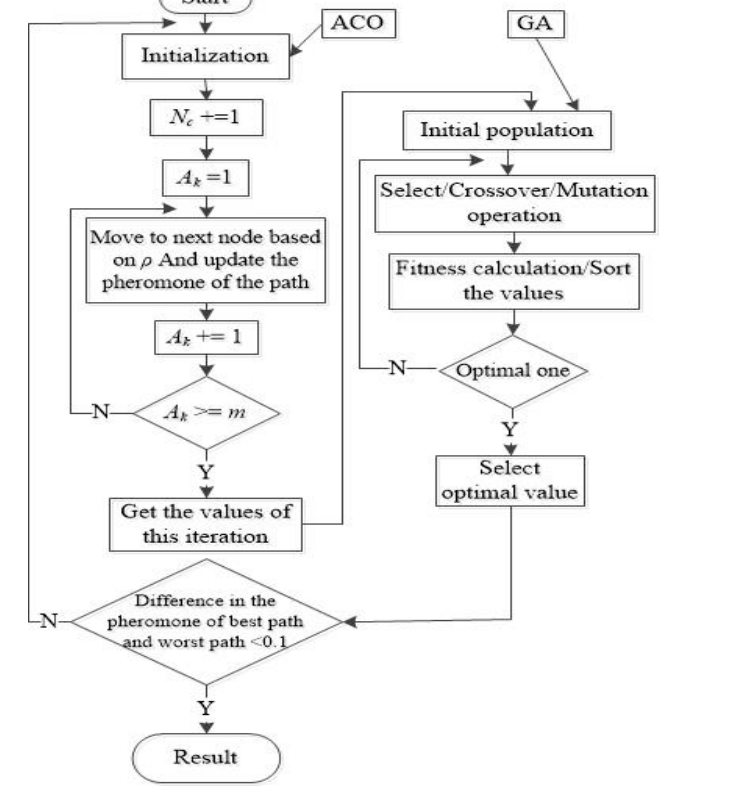
Figure 3. The flowchart of the proposed G-ACO.